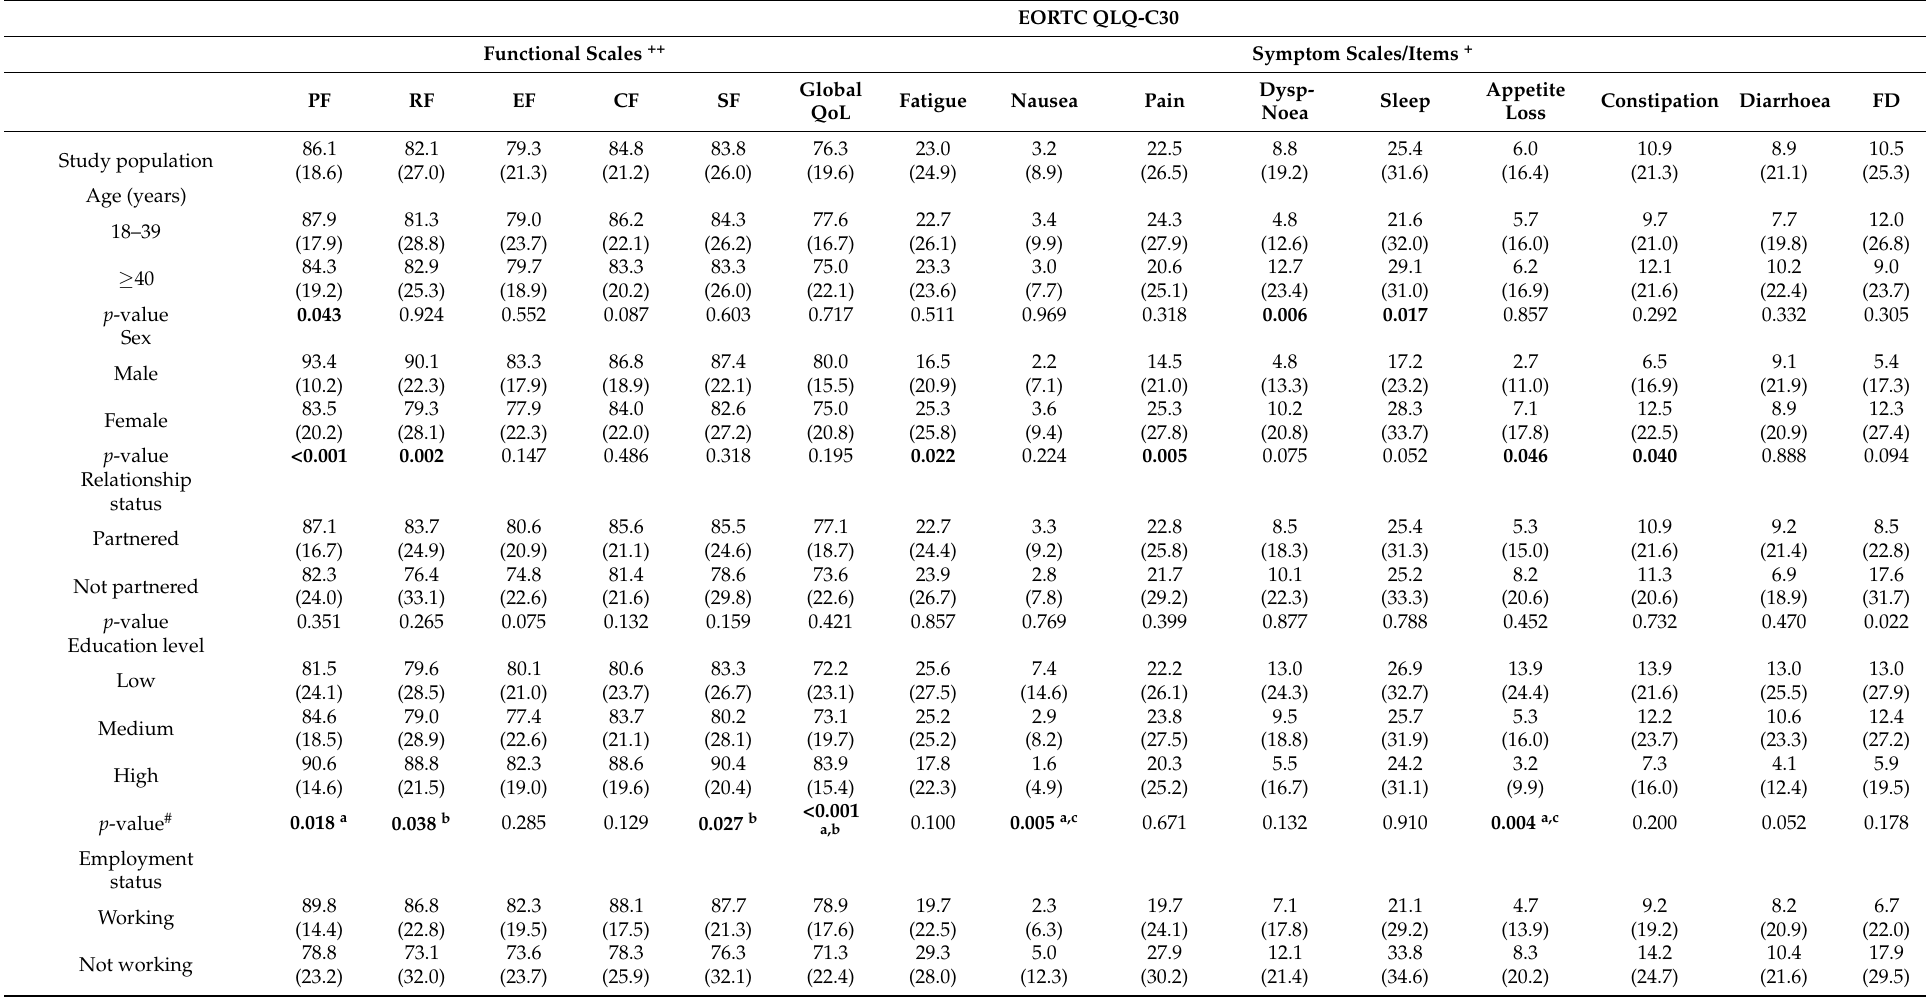
Table 3. Mean EORTC QLQ-C30 scores ( ± SD) in relation to socio-demographic and clinical